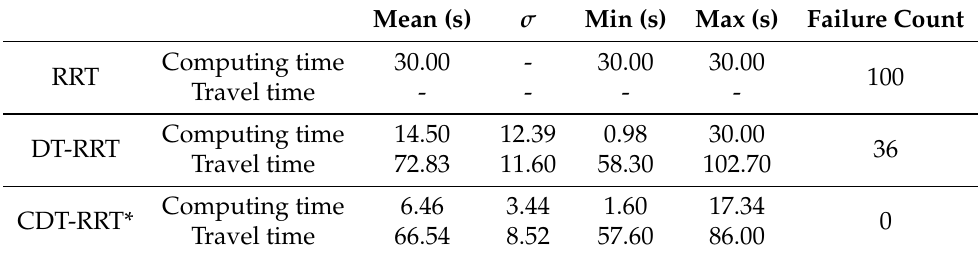
Figure 12. Histogram of the computing time for the results from simulation 5. Table 6. Summary of Planning Results from simulation 5.